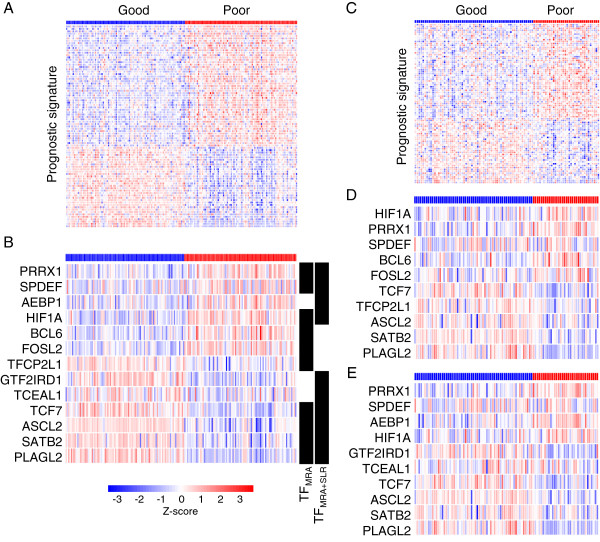
Expression patterns of the selected marker genes between the good and the poor prognostic group. The distinct expression pattern of (A) 85 signature genes and of (B) 13 TFs (union of TFMRA and TFMRA+SLR) are shown in the Moffit court (n = 177, training dataset). Differential expression pattern is observed to be well maintained in an independent test dataset (Melbourne cohort, n = 95) for (C) the 85 signature genes, (D) TFMRA, and (E) TFMRA+SLR after class prediction.